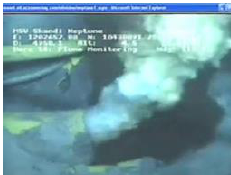
Table 2. The corresponding datasets for developing and testing of monitoring model.